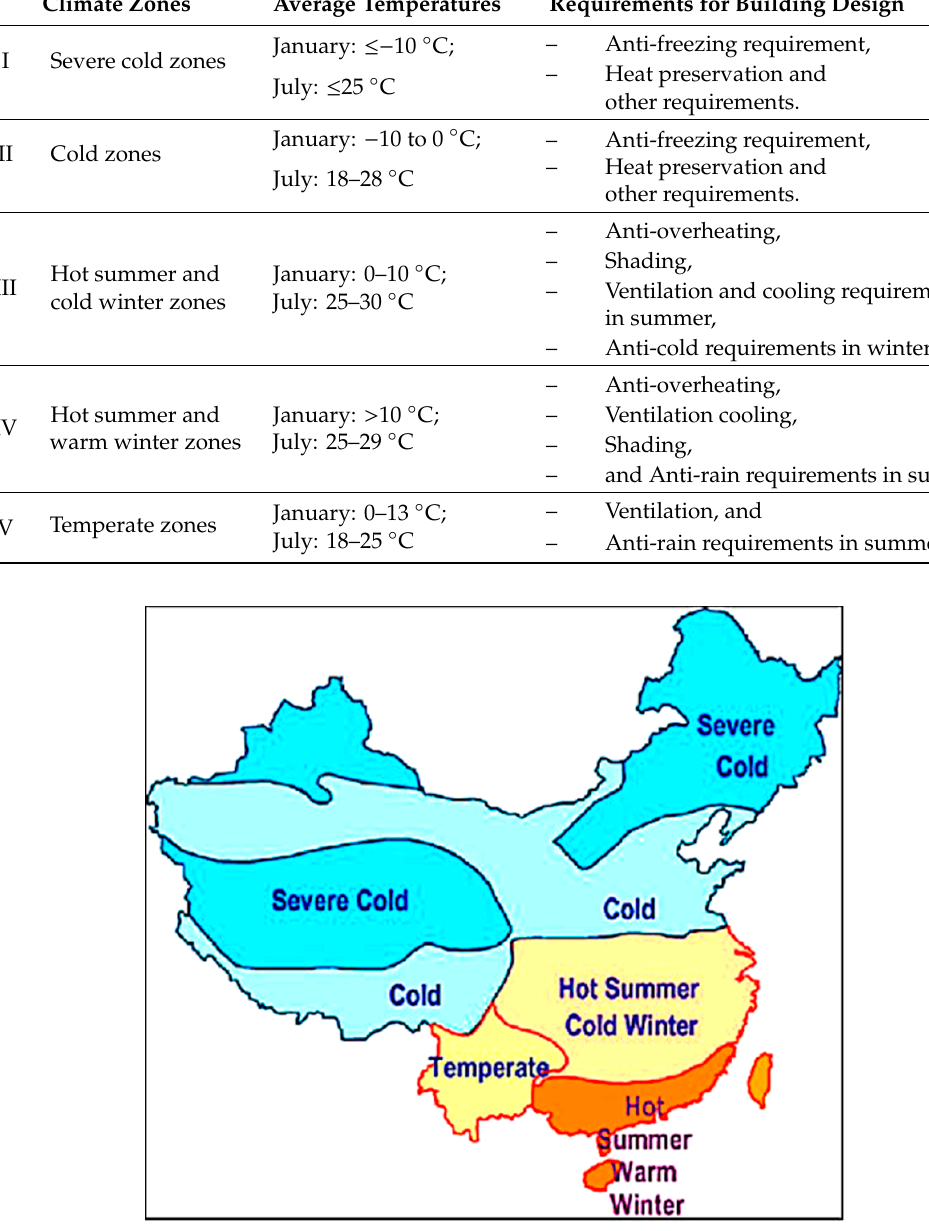
Figure 3. Climate zones of China.